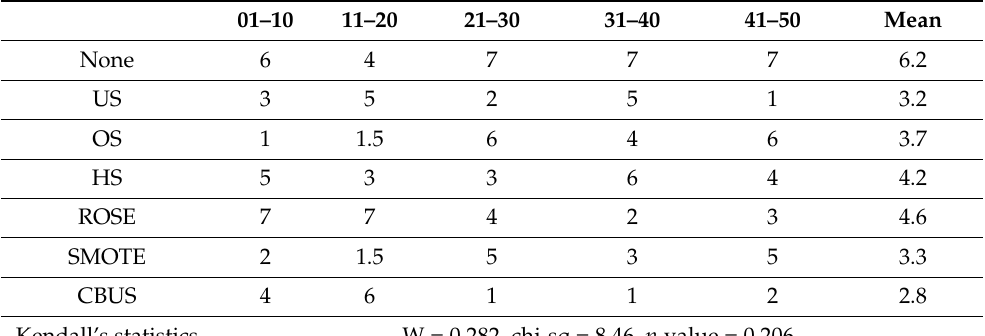
indicate the range of IR in the dataset. The values in each cell indicate the rank of DBT for varying levels of IR in the dataset for a given classifier. The last row in each table shows the results of Kendall’s test statistics. Table 15. Ranks of DBT for DT for varying levels of IR.